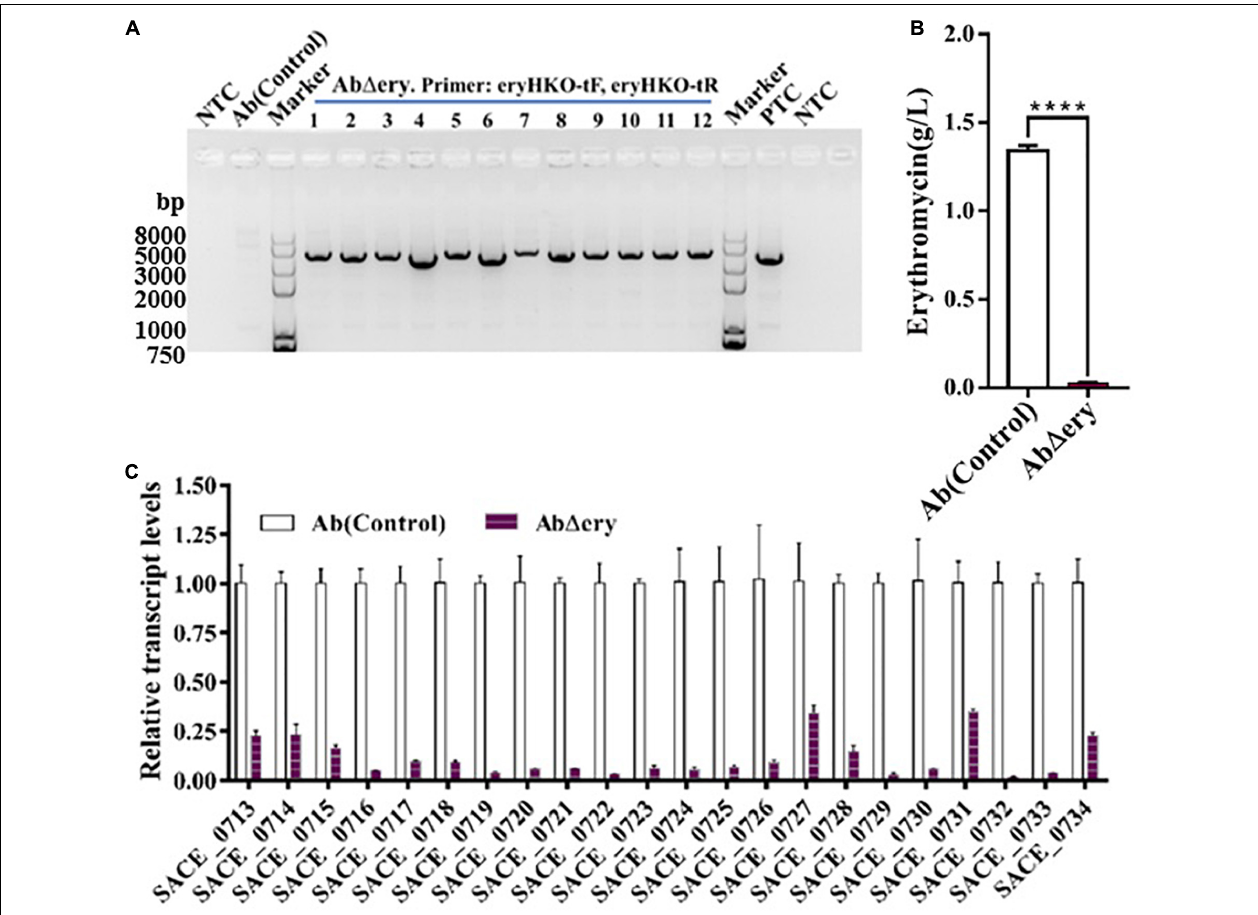
FIGURE 3 | Strain Ab (cid:49) ery lost the ability of erythromycin synthesis. (A) Agarose gel electrophoresis of PCR products from subcultured Ab (cid:49) ery to screen single colony using test primer pairs (eryHKO-tF, eryHKO-tR). The PCR products is 3083 bp. (B) Production of ErA in Ab and Ab (cid:49) ery grown in fermentation medium. (C) Transcriptional analysis of erythromycin BGC expression of Ab (cid:49) ery and Ab at 48 h. Relative transcript levels were obtained individually after normalization to the sigA (SACE_1801) internal reference gene. Gene expression values observed in the control strain (Ab) were set as 1.0. Error bars indicate the standard deviations from three independent